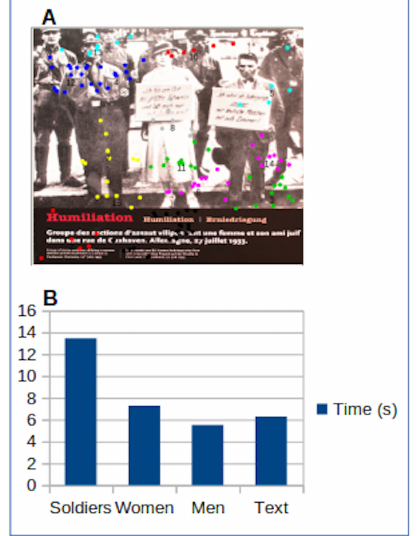
Figure 3. A. Projection of the fixation coordinates of the dif- ferent participants who looked at this image, each cluster being identified by a color. B. Graph of the time of fixations in sec- onds for thematic